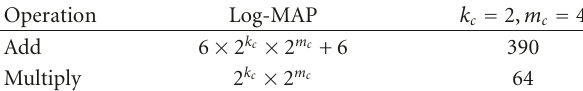
Table 3: Decoder complexity estimates